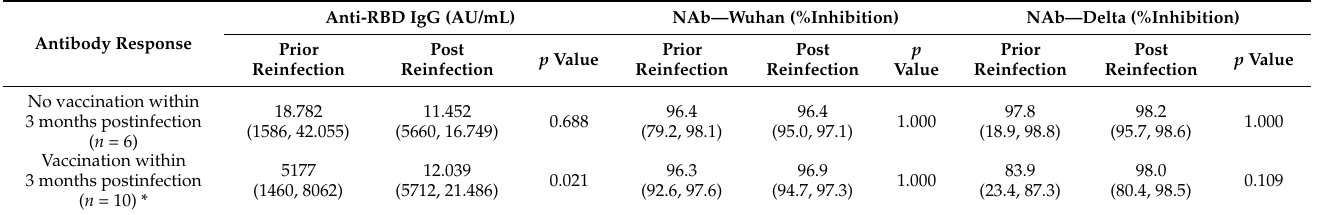
Table 6. Antibody responses levels at 3 and 6 months of COVID-19 reinfected participants who either received or did not receive a booster dose of COVID-19 vaccine. All antibody levels are presented as median (interquartile range); n =